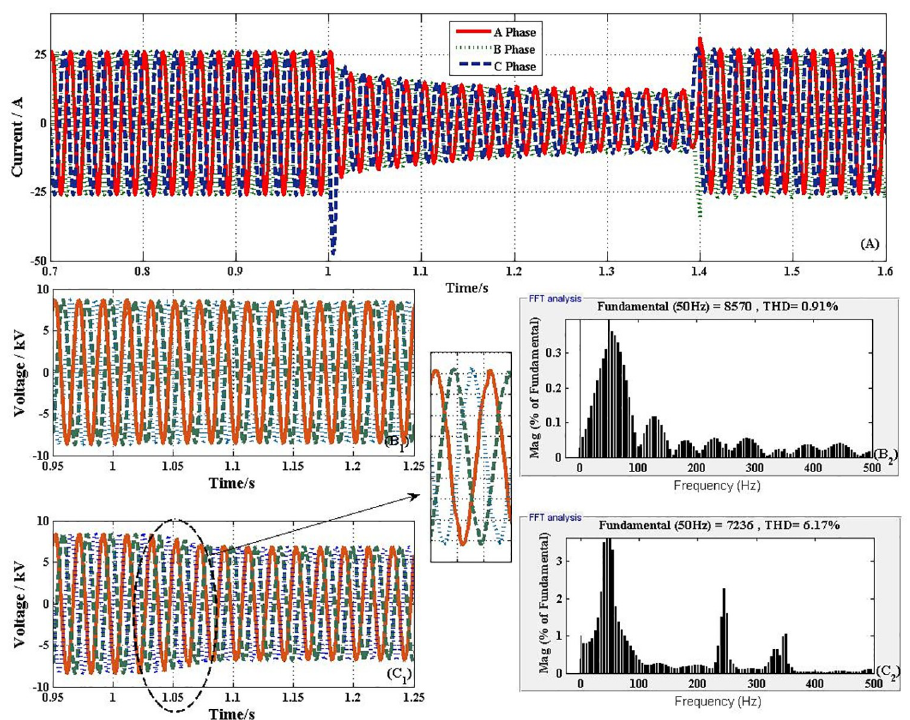
Fig 8. Transient performances curve of the voltage on both sides of NFFCLs 1 . (A) Current through NFFCLs 1 . (B) BUS 3 harmonic voltage and its THD without NFFCLs. (C) BUS 3 harmonic voltage and its THD with NFFCLs. NNFCL, (B) with SFCL, R = 10 O , (C) with SFCL, R = 5 O and (C) without FCL. Fig 9 SFCL SFCL shows the transient performances of distribution network, when a 3LG fault happens at F . 1